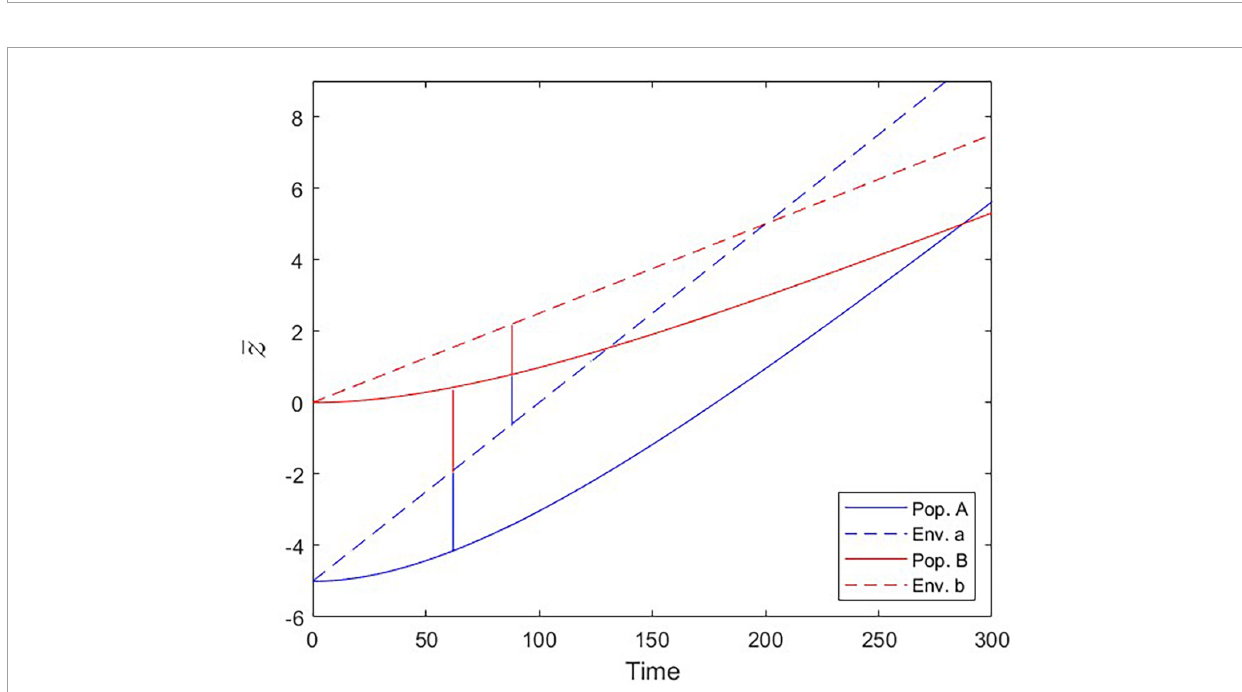
FIGURE7 Populations trailing the moving fitness optima over time (Scenario 3). Optimal trait values set by the environmental conditions (dashed lines) and trait values realized by populations A and B (solid lines). At the Local vs. Foreign criterion checkpoint ( t crit = 62), population B is as fit in environment a as population A is. At the Home vs. Away criterion checkpoint ( t crit = 88), population B is equally fit in environments a and b